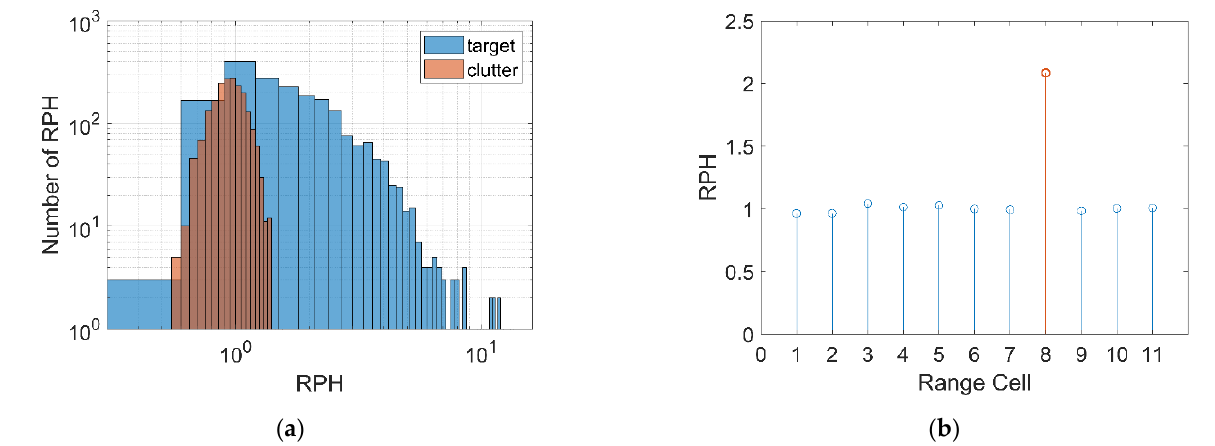
Figure 6. Relative value of Doppler peak height (RPH) feature of the first dataset. ( a ) the histogram of RPH at the primary cell where target exists and randomly selected clutter-only cell; ( b ) the average RPH of radar echo in each range cell.